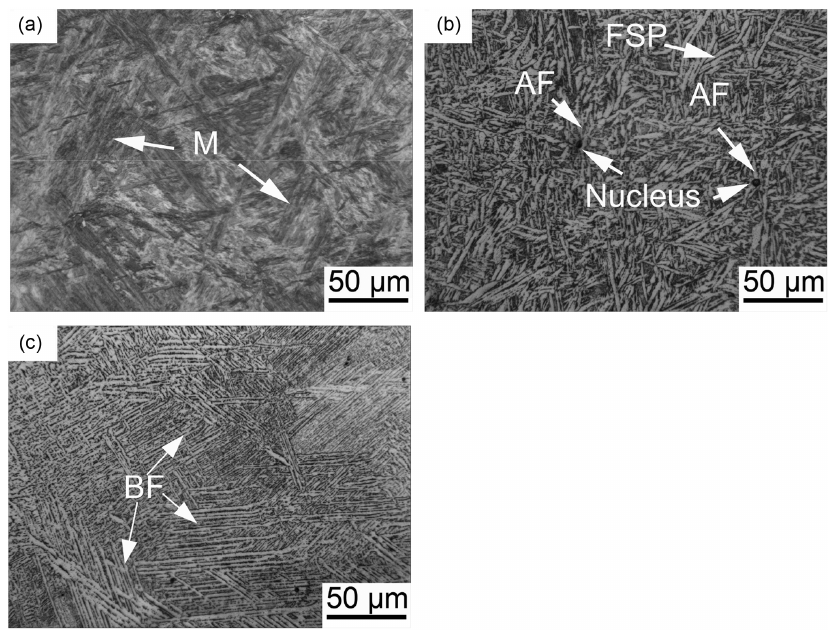
Figure 1: The microstructure in steels with different content of Al (a) AR1, (b) AR2 and (c)